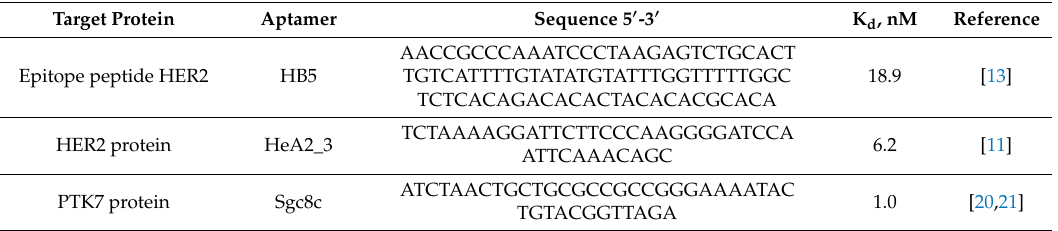
Table 1. Sequences of DNA aptamers used in experiments. K d is the dissociation constant. Target Protein